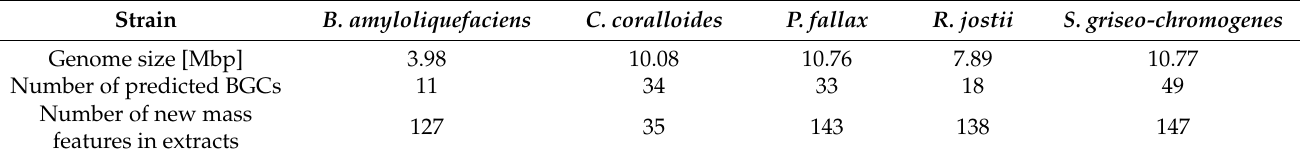
Table 6. Genome size, numbers of predicted BGCs, and numbers of detected new mass features per strain.